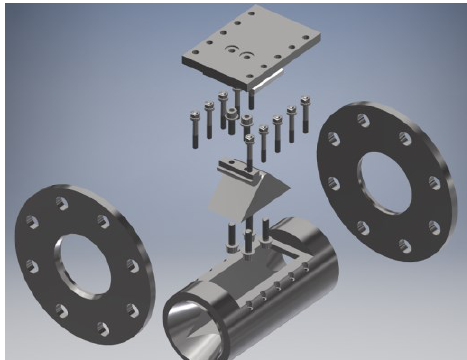
Fig. 3. The geometric model of cavitation tunnel - components.